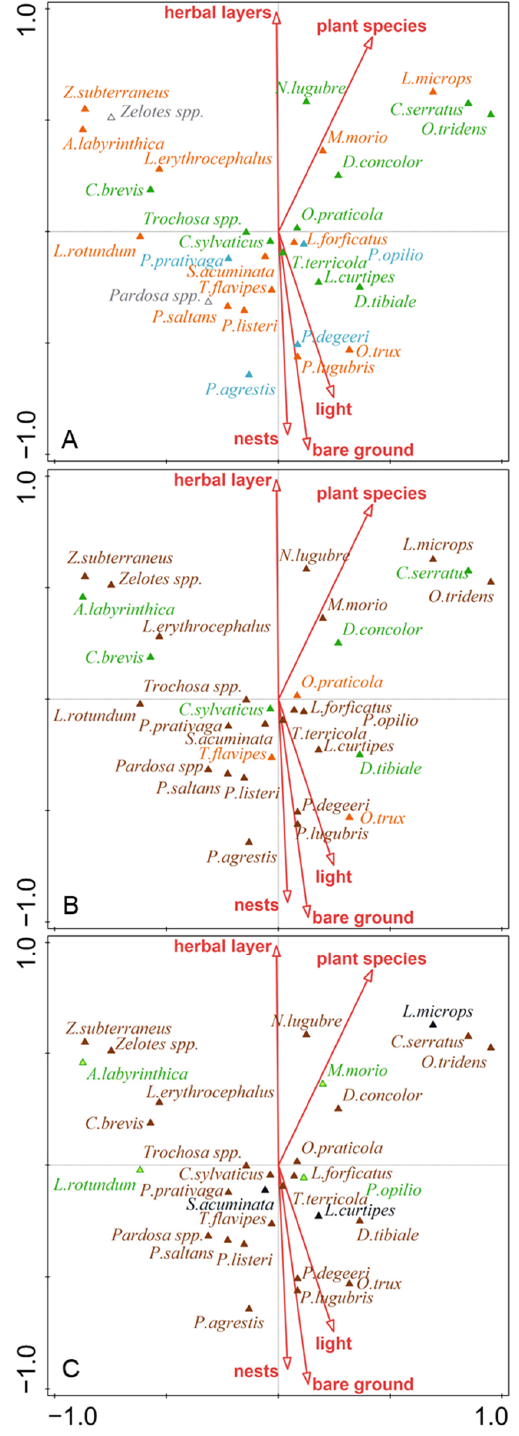
Figure 2. CCA biplots of selected groups of predatory arthropod distribution in cormorant colonies with significant factors predicting their activity-density: ( A ) guilds according to habitat preference (green—forest species; orange—eurytopic species; blue—non-forest species); ( B ) guilds according to hunter strategy guilds (green—sheet web hunters; orange—ambush hunters; brown—ground hunters); ( C ) preferred stratum guilds (brown—epigeic species; green—herb species; black—soil living species). Bare ground—patches without vegetation; herbal layer—coverage (%) of ground by herbs; plant species—number of plant species; light—Ellenberg indicator values for light; nests— mean number of cormorant nests per 100 m 2 .